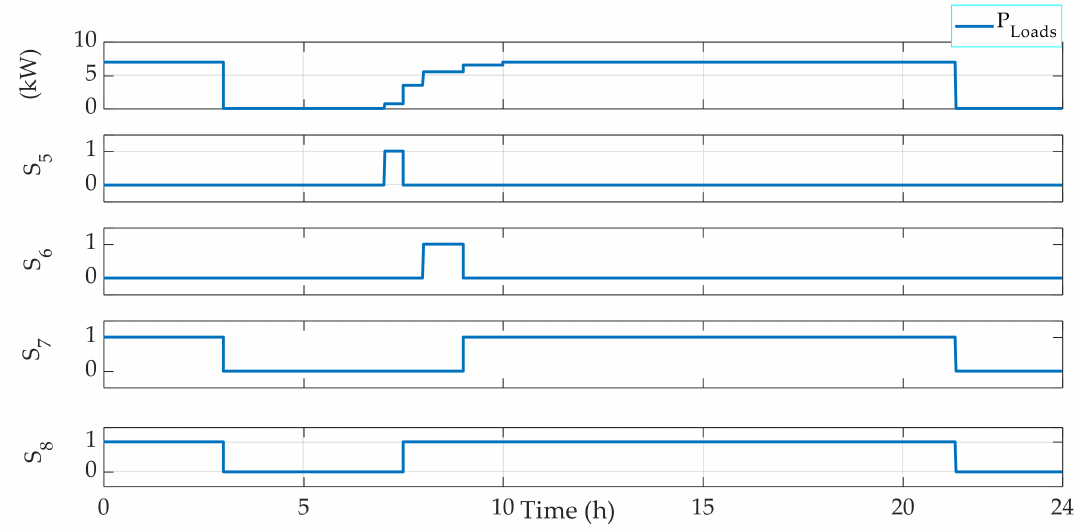
Figure 5. Loads energy management